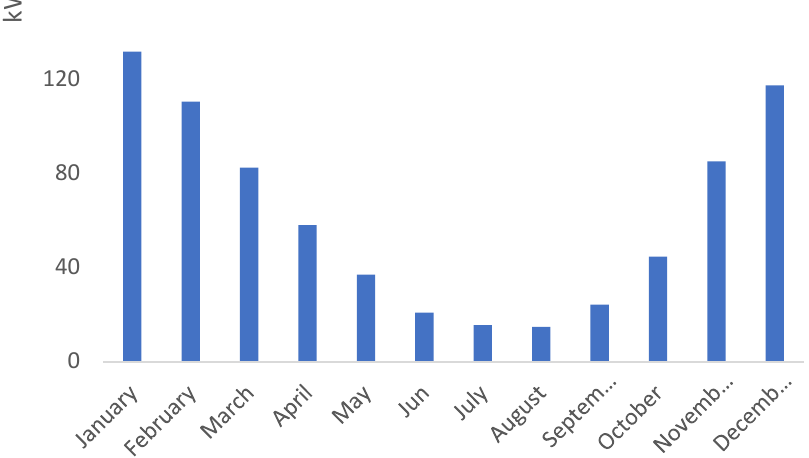
Figure 7. The average monthly heat demand of the group of buildings in a typical year.